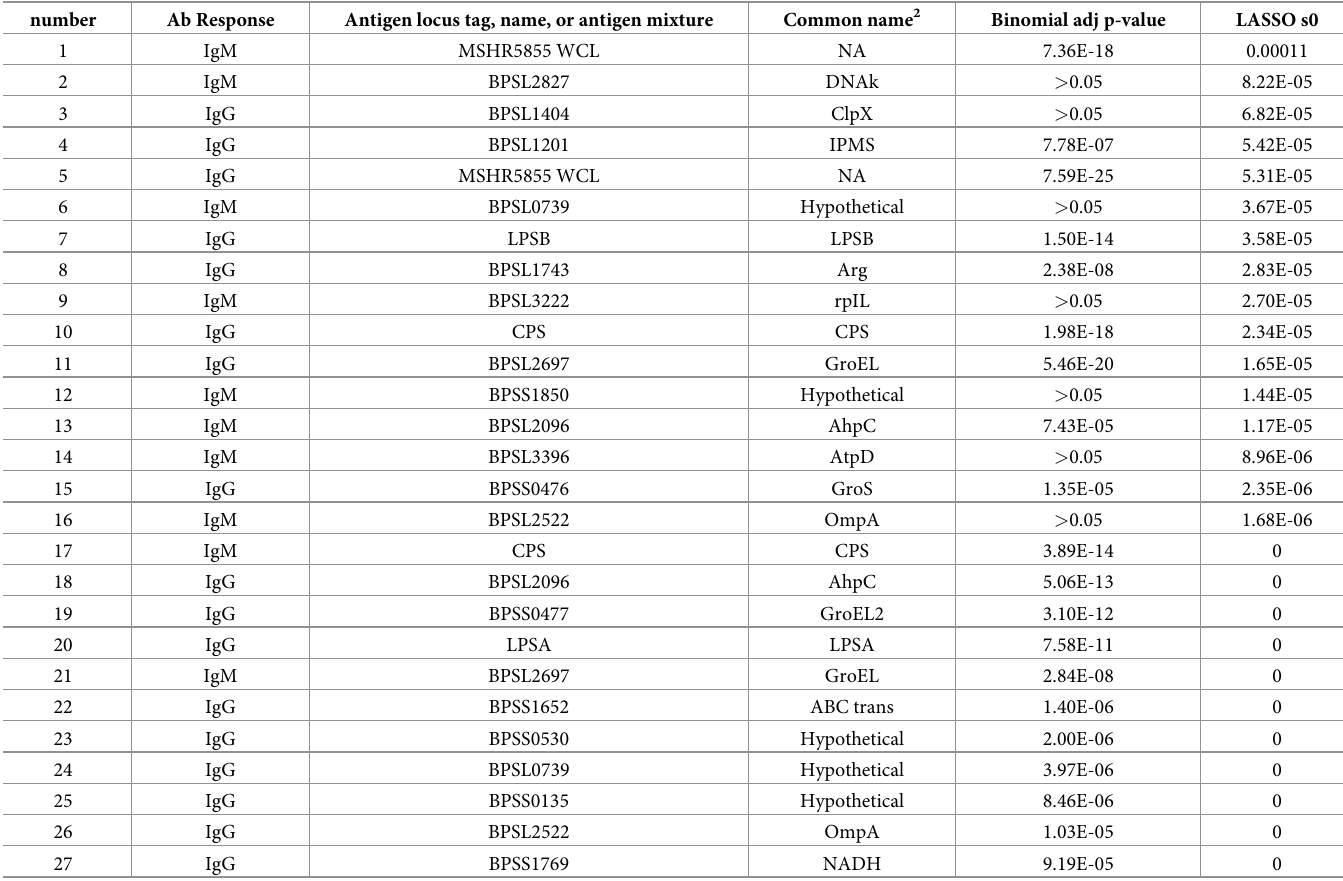
Table 5. Antigens and the associated antibody response that contributed to a binomial or LASSO logistic regression models 1 .